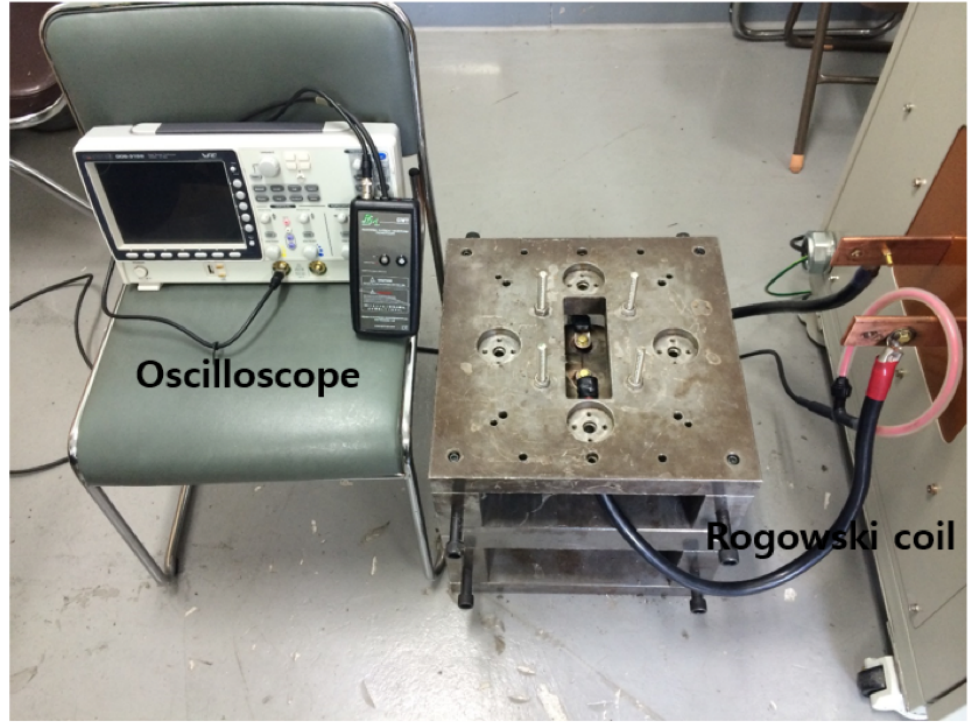
Figure 3. Input current measurement with a Rogowski coil and monitoring with an